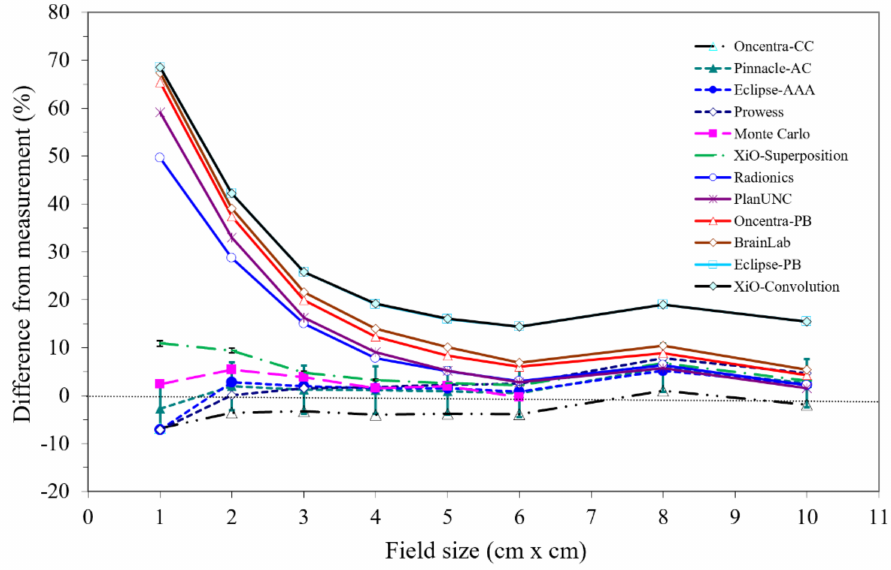
Figure 6. Differences between measured and TPS calculated doses from different algorithms at 10.5 cm depth. Graphs are separated in two groups by the type of algorithm. For a very small fields, very large differences (+70%) are noted in type-A (pencil beams) and smaller ( ± 10%) in type-B algorithms (collapsed